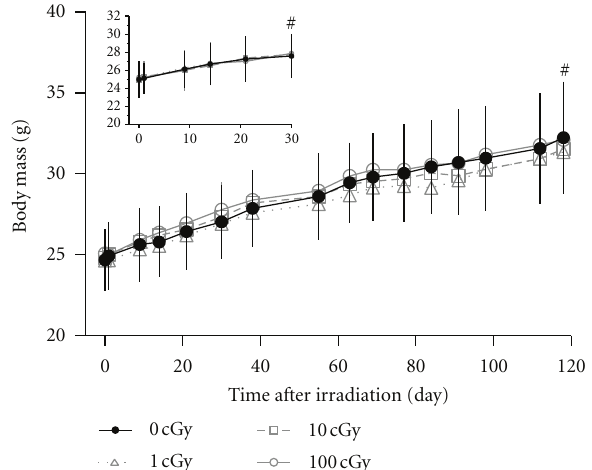
Figure 1: Mouse body mass as a function of age and radiation exposure. Experiment to determine whether a single dose of 137 Cs gamma rays causes age-related changes in skeletal structure and bone cell di ff erentiation. Male C57BL/6 mice (10 weeks of age, n = 8/group) were irradiated at 1, 10, and 100 cGy or were sham- irradiated (0cGy) on day 0 and tissues harvested 1 month (inset) or 4 months after irradiation. Mean ± SD. # Denotes P < 0 . 05 for changes with age (linear regression) for the respective cohorts (1 and 4 months after